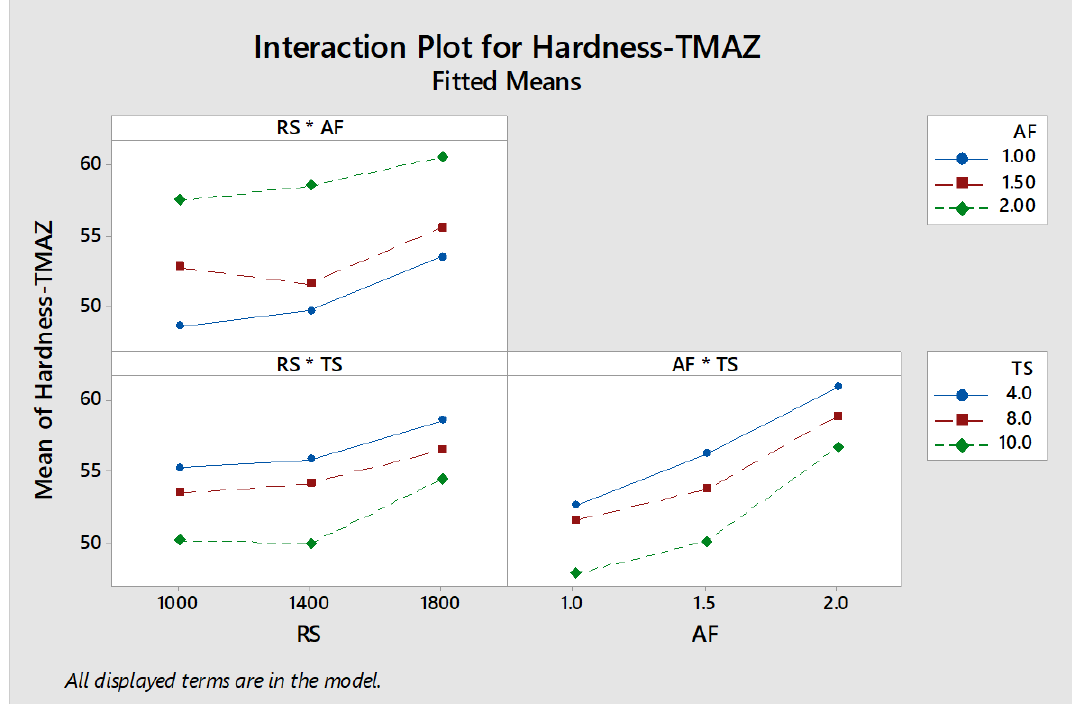
Figure 18. Interaction plots — hardness in TMAZ.